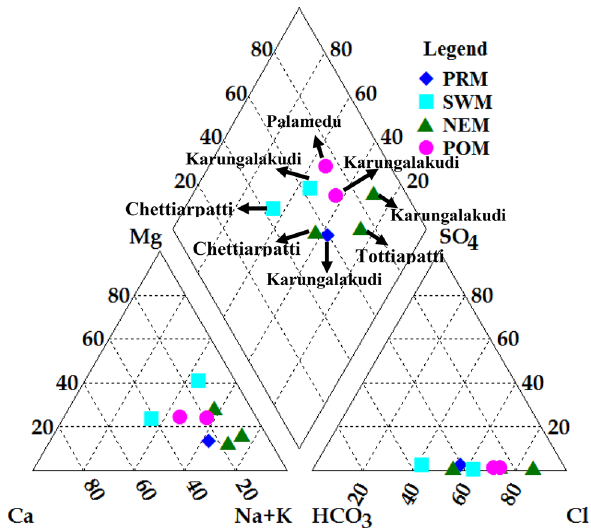
Fig. 5 Migration of U identified through piper plot for groundwater